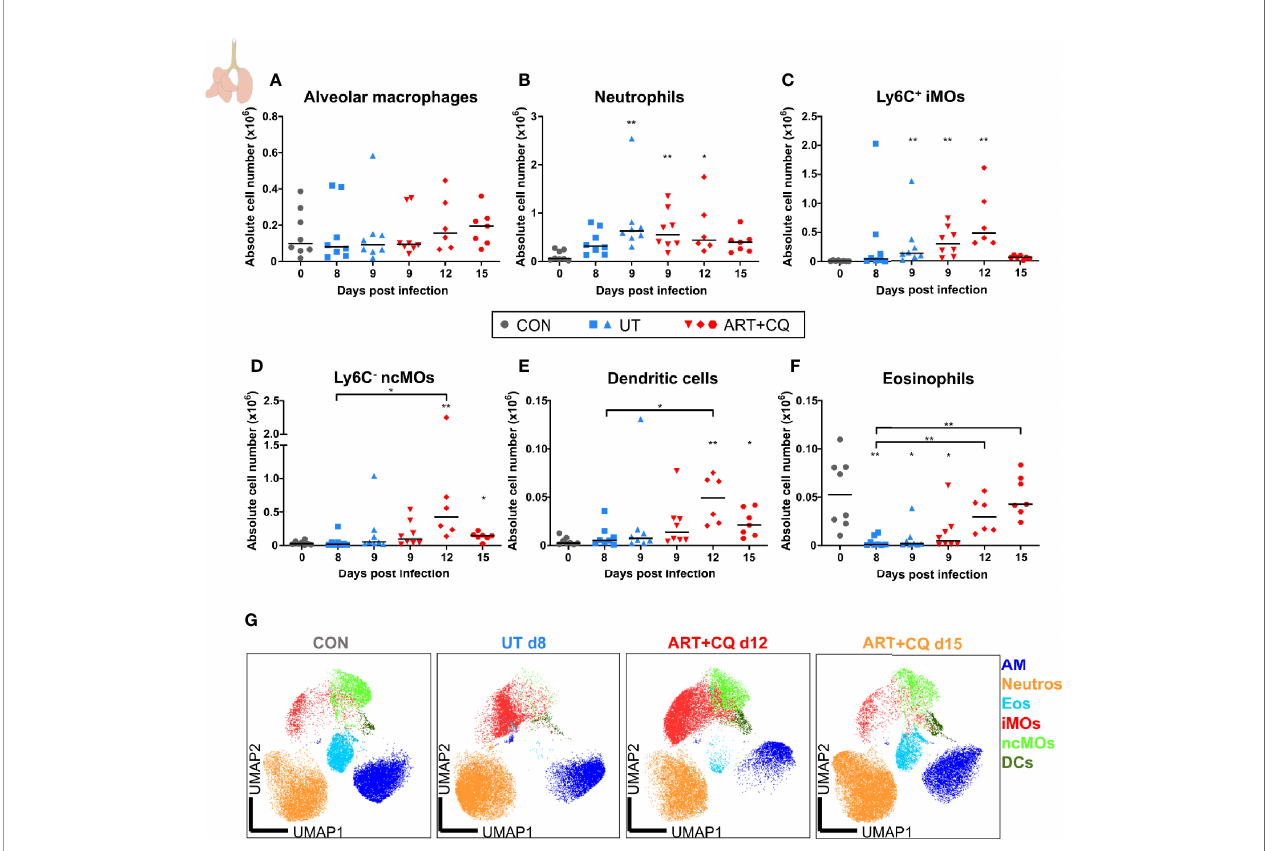
FIGURE 3 | Dynamics of the myeloid cell populations in the lungs during resolution of malaria-associated acute respiratory distress syndrome (MA-ARDS). C57BL/6 mice were infected with Pb NK65. Mice were injected daily from 8 until 12 days p.i. with 10 mg/kg ART + 30 mg/kg CQ. Mice were dissected at the indicated days p.i. Leukocytes were isolated from the lungs according to protocol 1 and fl ow cytometry was performed. (A – F) The absolute numbers of alveolar macrophages (AM; CD45 + SiglecF + CD11b int CD11c + ), neutrophils (Neutros; CD45 + Lin − CD11b + Ly6G + ), Ly6C + in fl ammatory monocytes (iMOs; CD45 + Lin − CD11b hi MHC-II − Ly6C + ), Ly6C − non-classical monocytes (ncMOs; CD45 + Lin − CD11b hi MHC-II − Ly6C − ), dendritic cells (DCs; CD45 + Lin − SiglecF − MHC-II + CD11c + ), and eosinophils (Eos; CD45 + CD11b + SiglecF + CD11c − ) in the lungs were calculated. Compilation of two experiments. Each symbol represents data of an individual mouse. n=8 for CON on day 0, UT at 8 and 9 days p.i and ART+CQ at 9 days p.i., n=6 for ART+CQ at 12 days p.i., n=7 for ART+CQ at 15 days p.i. (G) Clustering of 24,000 cells combined from four representative samples per condition, except ART+CQ d15 from two representative samples. The plots show a two-dimensional representation (UMAP) of the protein expression. Clusters are colored by cell class as de fi ned in (A – F)